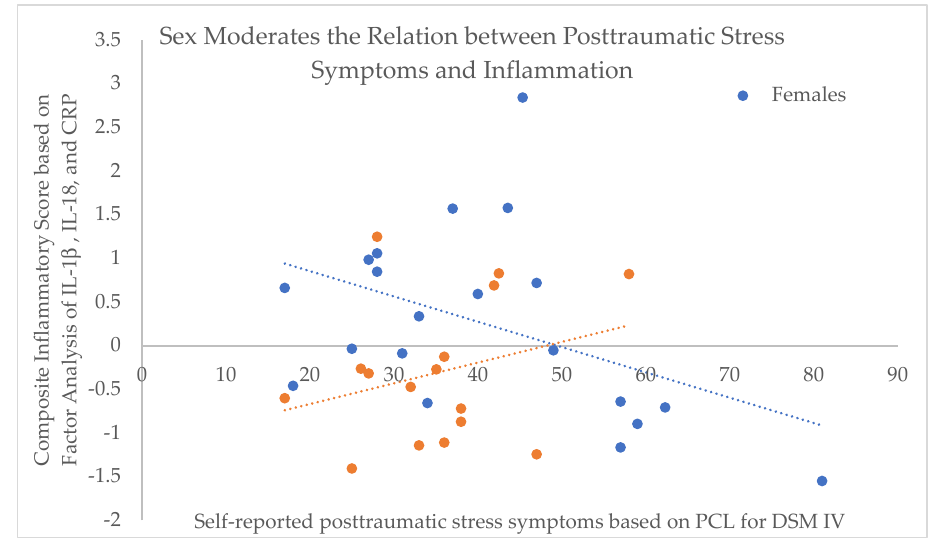
Figure 3. Moderation analysis provides evidence towards a potential role of sex on the relation between post-traumatic stress symptoms and pro-inflammatory variables (IL-1 β , IL-18, and CRP).